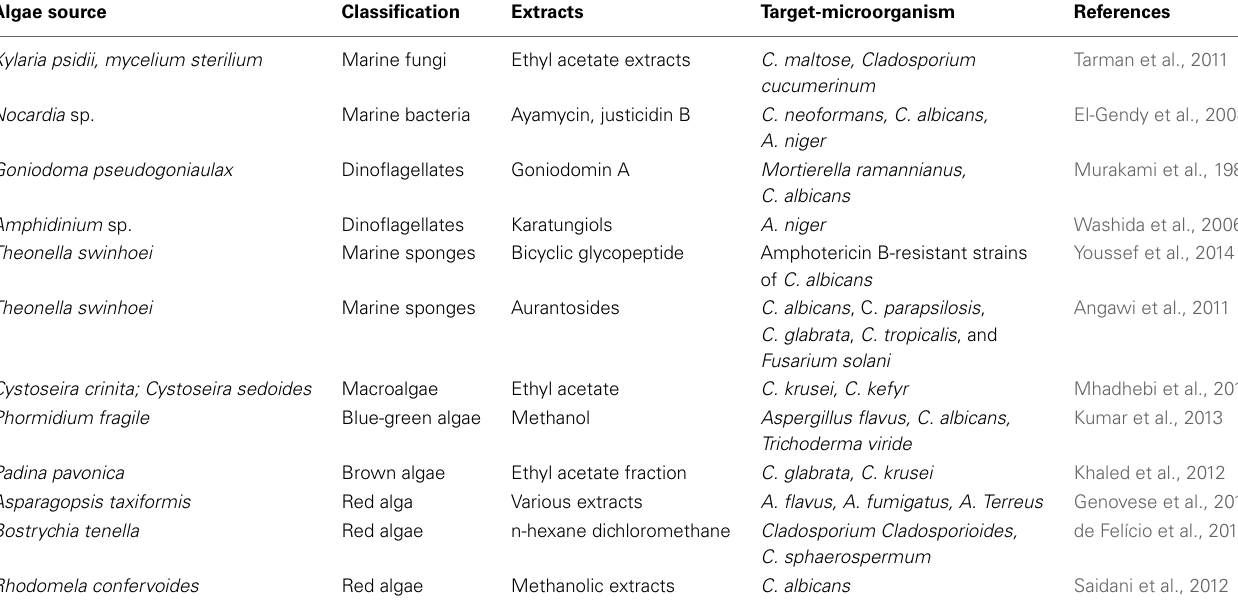
Table 2 | Natural products from marine organisms with antifungal